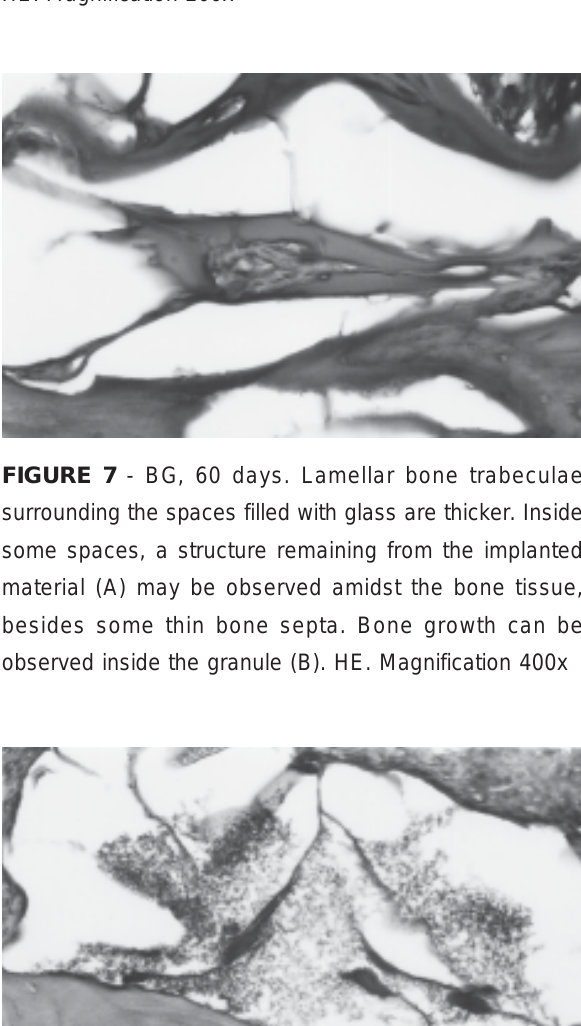
FIGURE 6 - PG, 60 days. Thicker lamellar bone trabeculae surrounding the spaces taken up by glass; interspersed with bone marrow (A), with indications of bone remodeling. HE. Magnification 200x